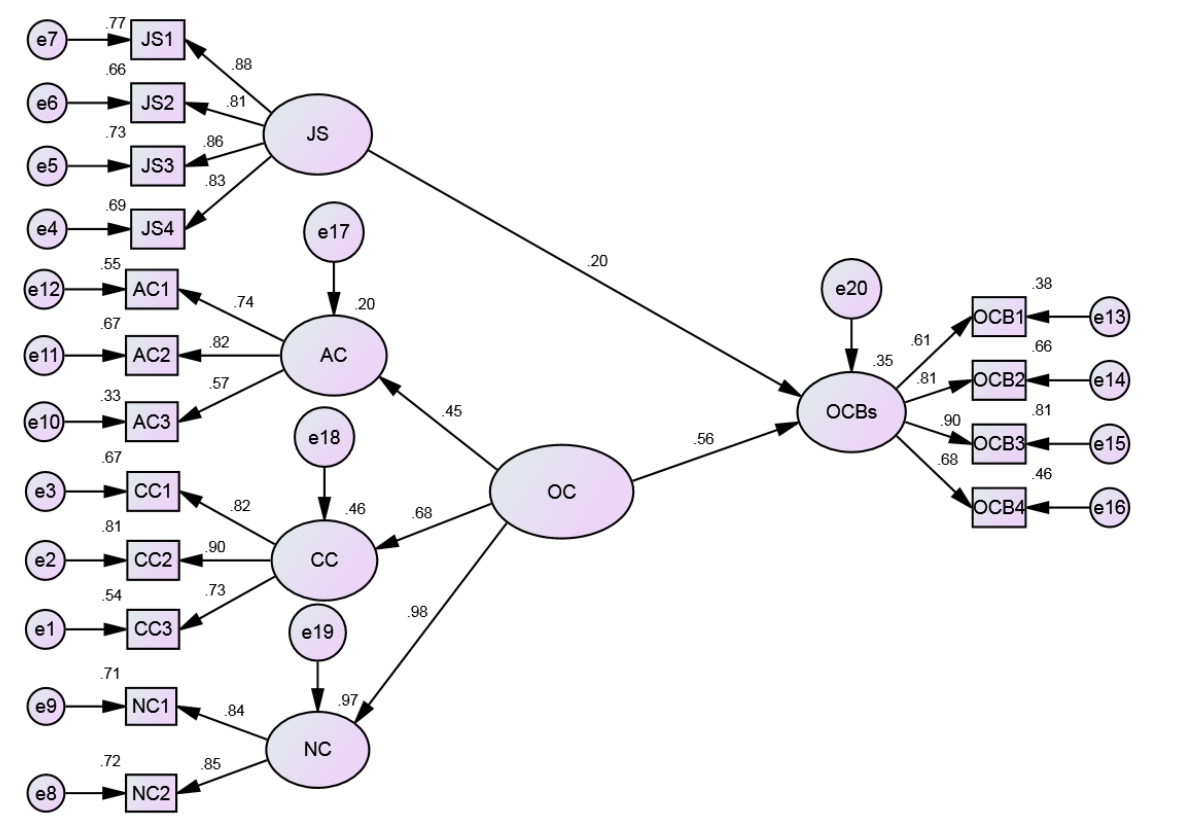
structural model